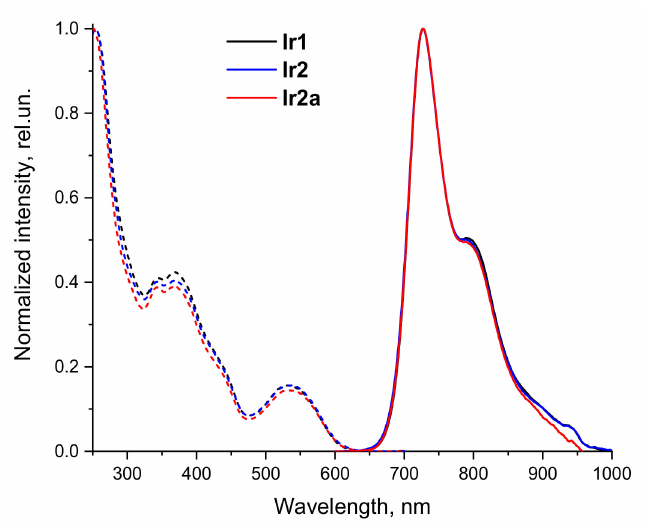
Figure 3. Normalized excitation (dashed lines) and emission (solid lines) spectra of Ir1 , Ir2 , and Ir2a in aqueous solution at 298 K. Table 1. Photophysical data for complexes Ir1 , Ir2 , and Ir2a in aerated and degassed aqueous solution at 298 K (absorption, excitation and emission spectra, quantum yield) and 310 K (phosphorescence lifetime